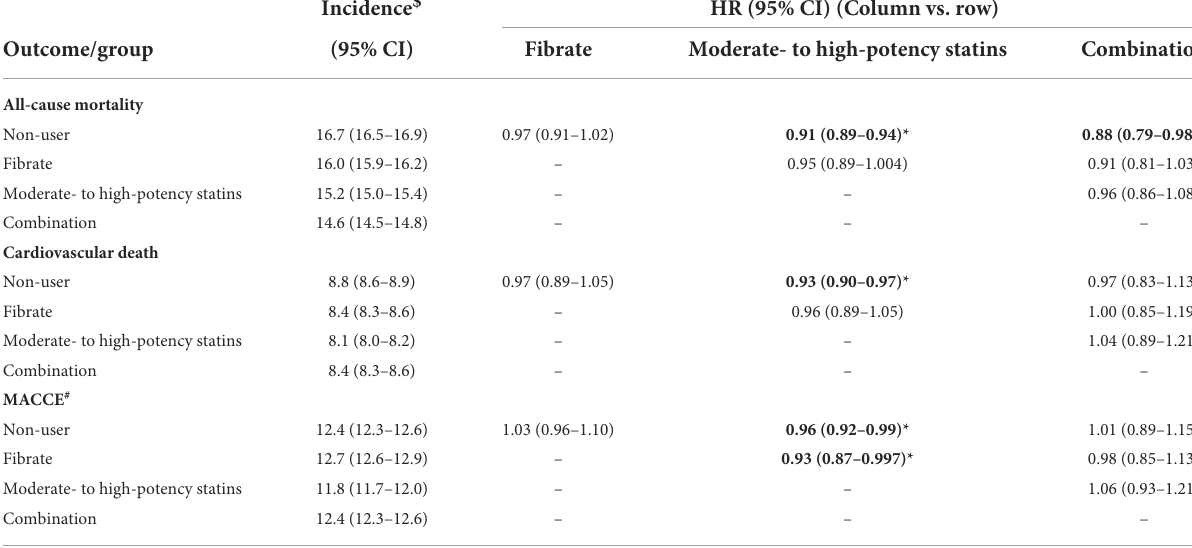
TABLE 3 Follow up outcomes for the dialytic patients according to the use of fibrate and moderate- to high-potency statins in the IPTW-adjusted cohort. Incidence $ HR (95% CI) (Column vs.